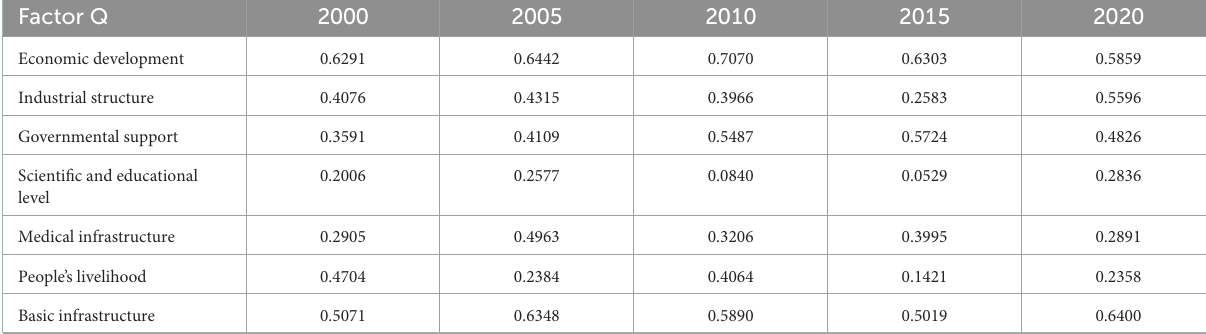
TABLE 4 Factor detection results of influencing factors of integrated urban-rural